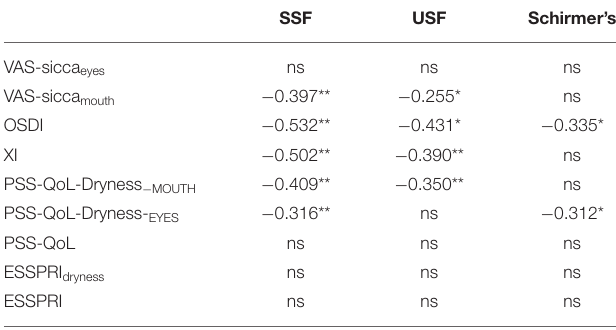
TABLE 1 | Patient characteristics and clinical variables. TABLE 2 | Correlation between objective and subjective dryness